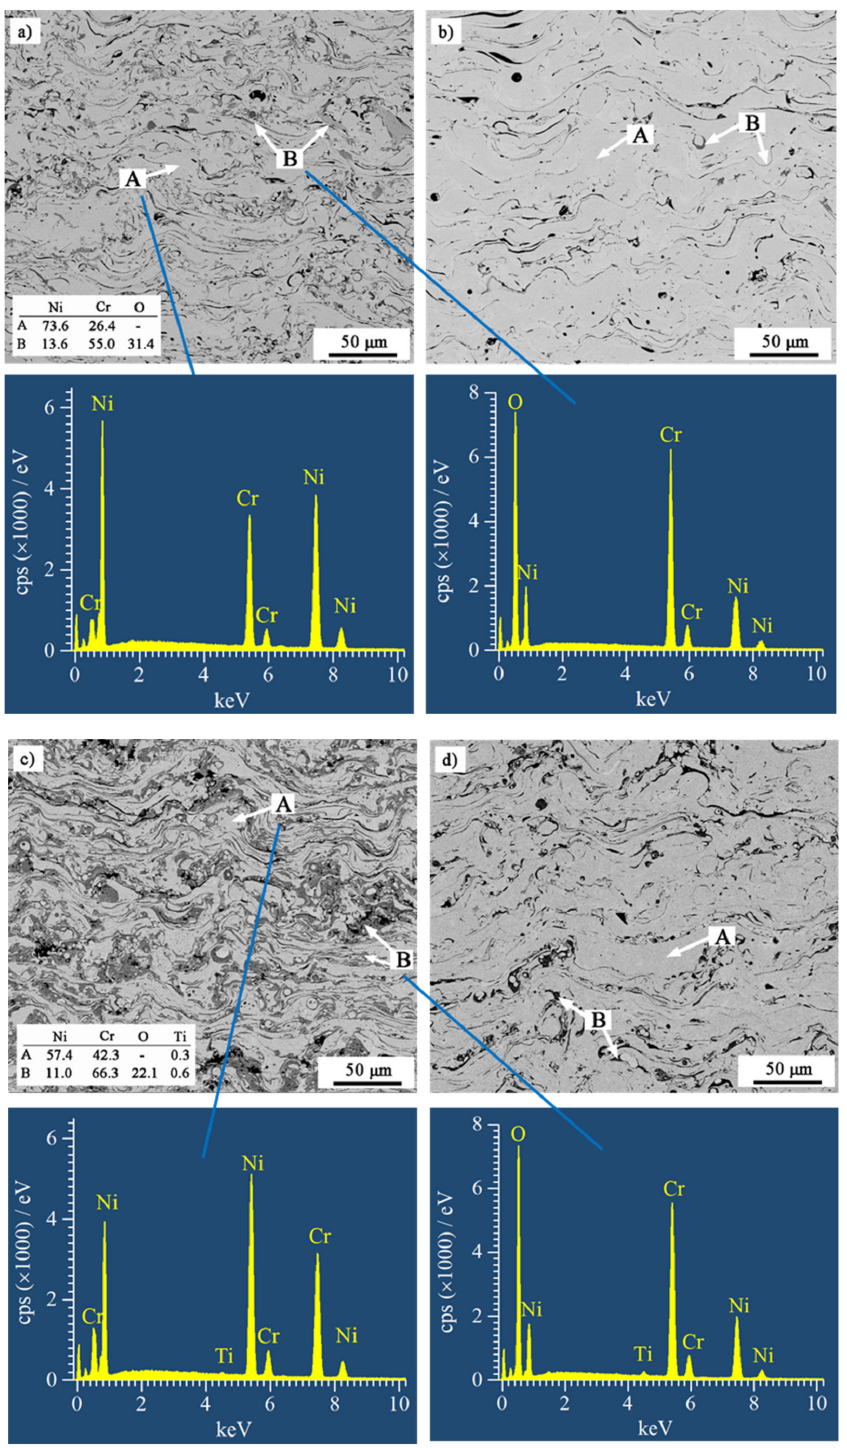
Figure 2. BSE SEM-images of cross-sections of the as-sprayed ( a ) NiCrB-Air, ( b ) NiCrB-N 2 , ( c ) NiCrTi- Air, and ( d ) NiCrTi-N 2 , corresponding with the EDS results of the phases in the